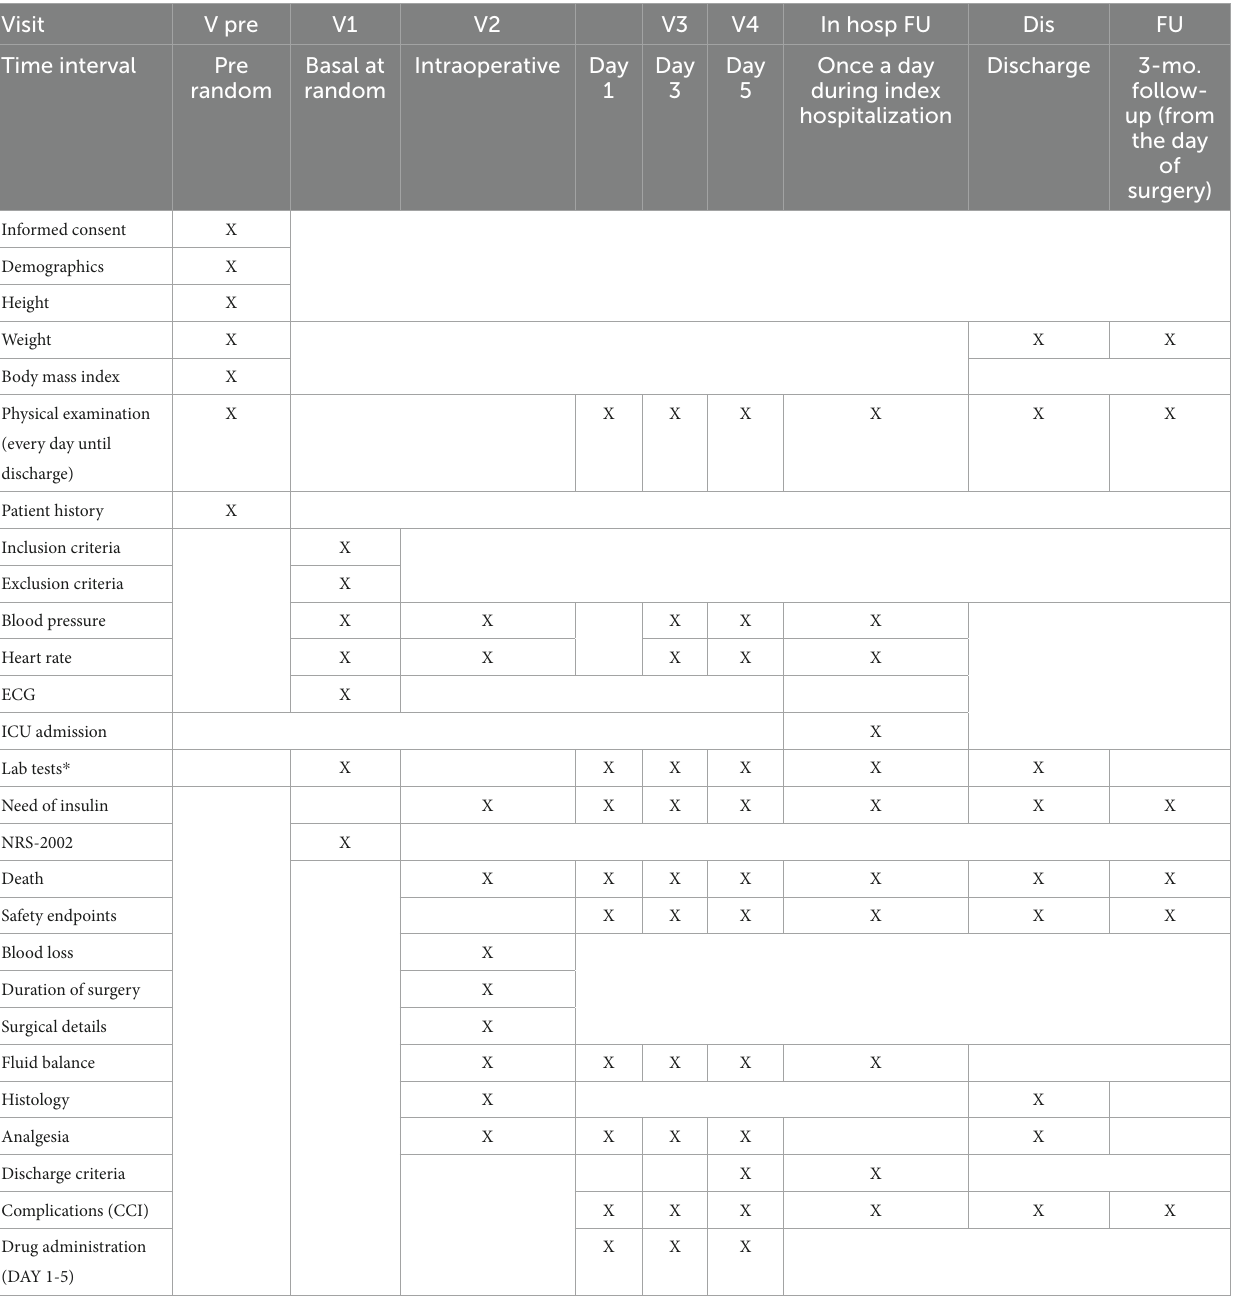
TABLE 2 Study plan and schedule of